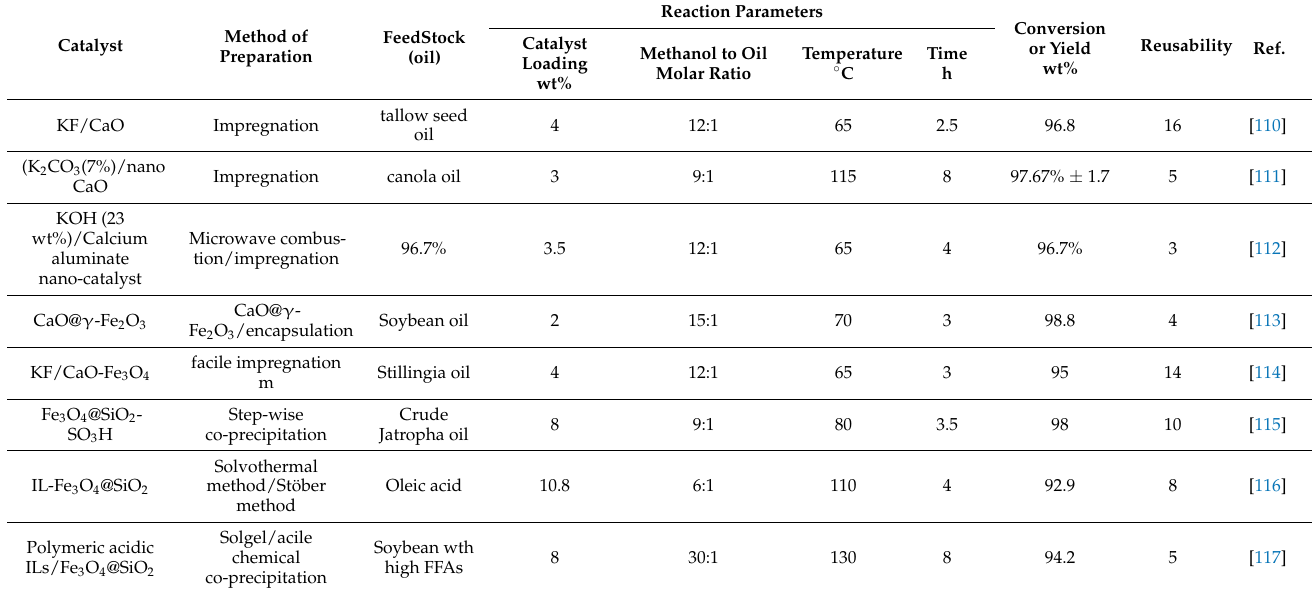
Table 4. Some novel nano-heterogeneous-based catalysts for biodiesel